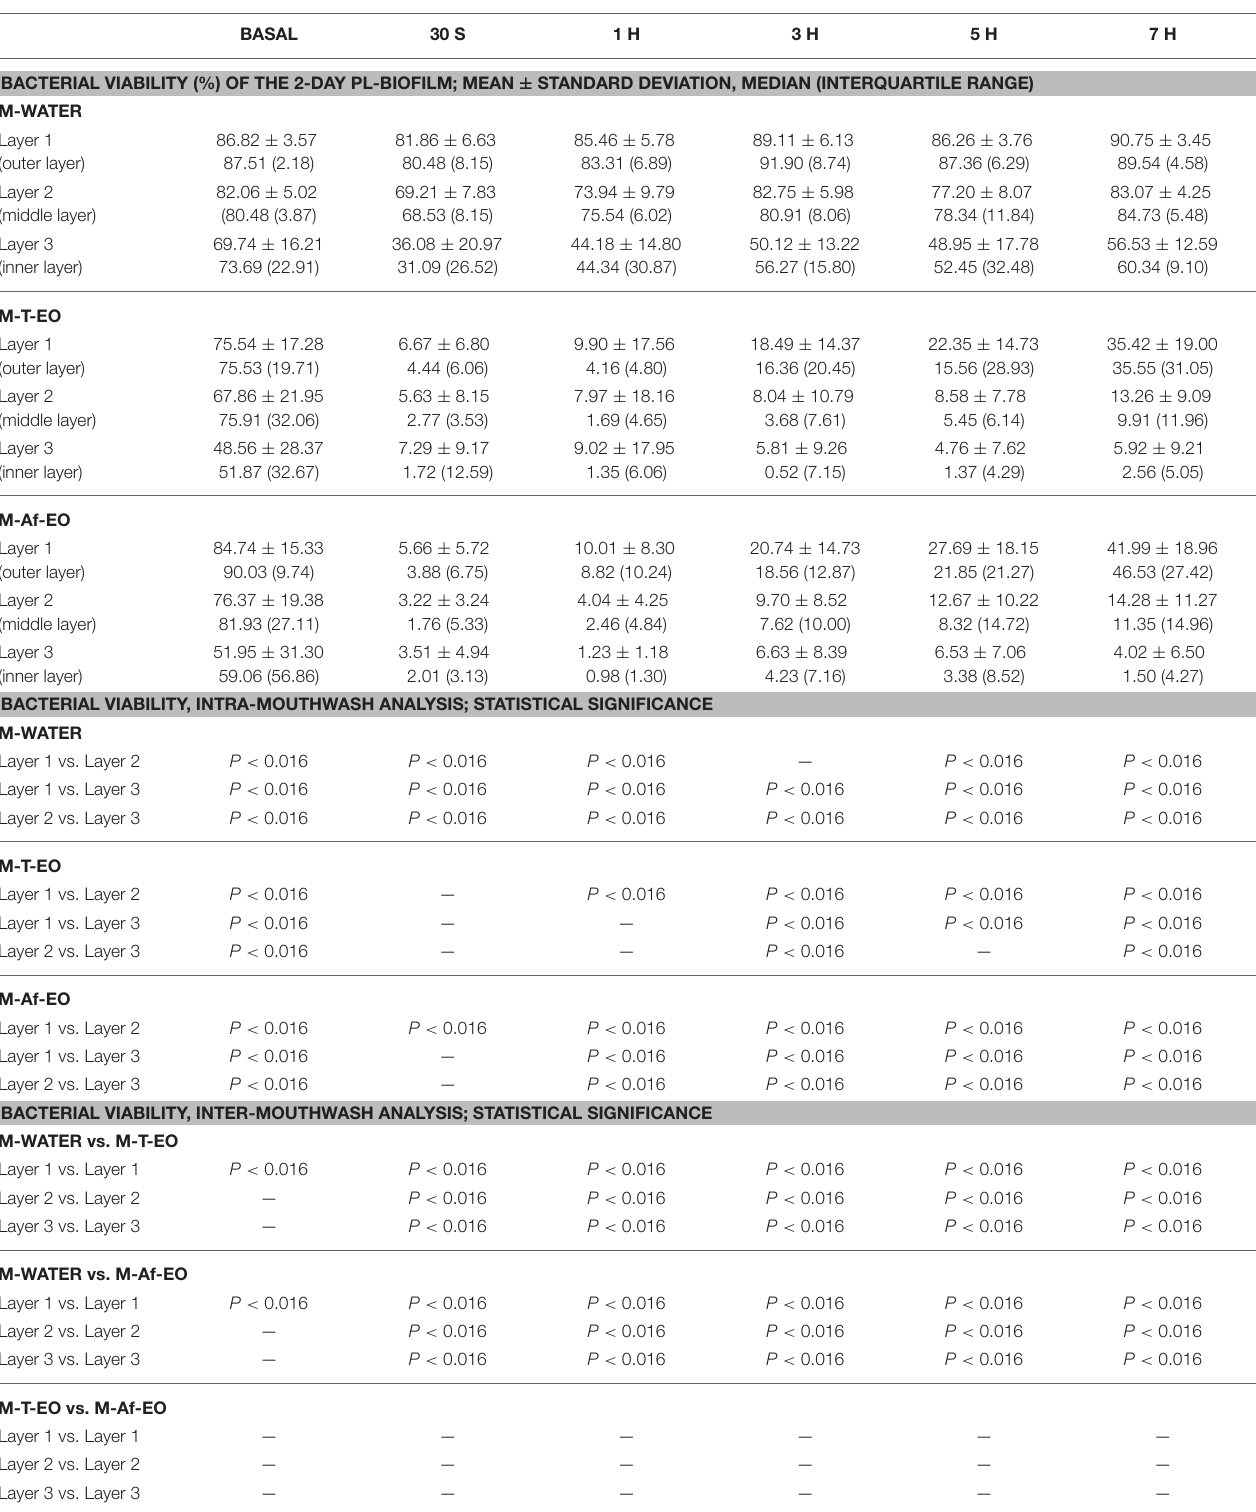
Layer 3 vs. Layer 3 — — — — — — Differences between the three biofilm layers, as well as intra-mouthrinse and inter-mouthrinse comparisons. M-WATER, A single, 30-s mouthwash with 20mL of sterile water; M-T-EO, A single, 30-s mouthwash with 20mL of a traditional essential oils solution; M-Af-EO, A single, 30-s mouthwash with 20mL of an alcohol-free essential oils solution. —, no statistical